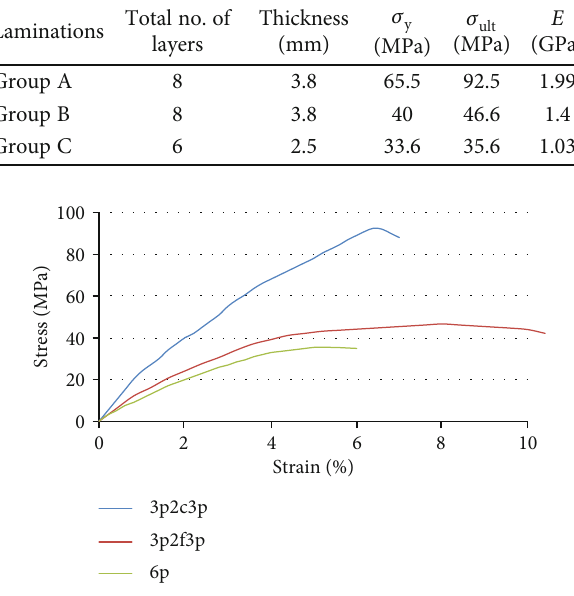
Figure 8: Tensile test curve for each group.